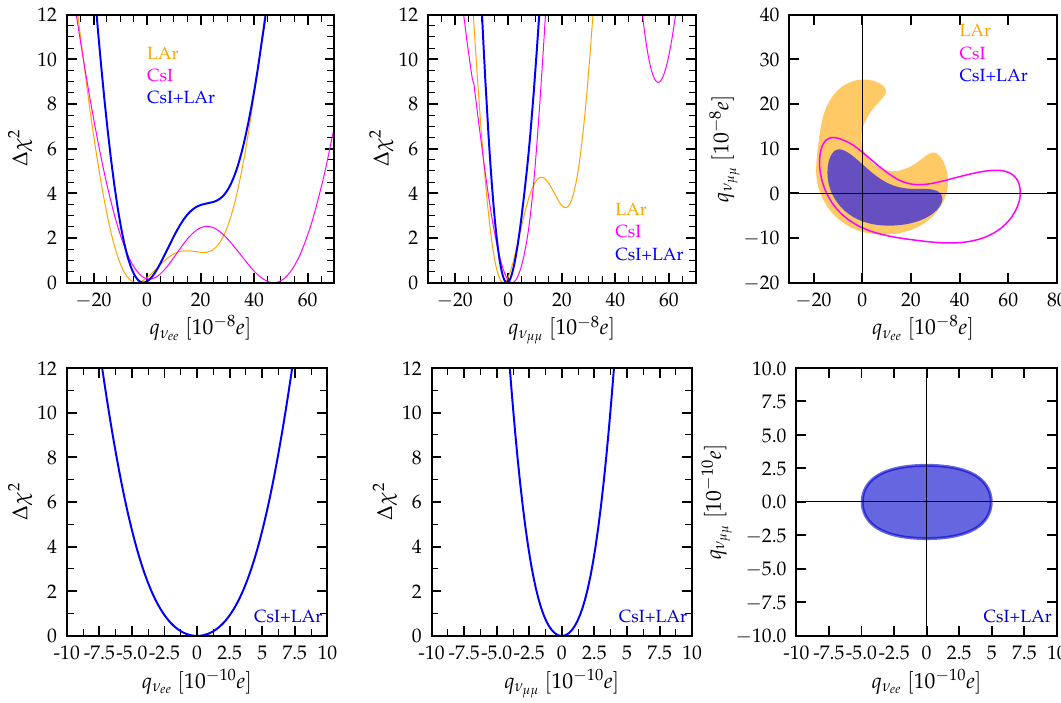
Figure 13 . Left and middle panels: ∆ χ 2 profile for the neutrino electric charges obtained from the analysis of CsI (magenta), LAr (orange) and CsI + LAr (blue) data. Right panels: 90% C.L. (2 dofs) allowed regions for the neutrino electric charges, in units of the elementary charge e . In the upper (lower) panels the analysis of CsI data includes only CE ν NS (CE ν NS+ES) interactions. In the lower panels, we do not show LAr contours as the combined analysis is driven by CsI